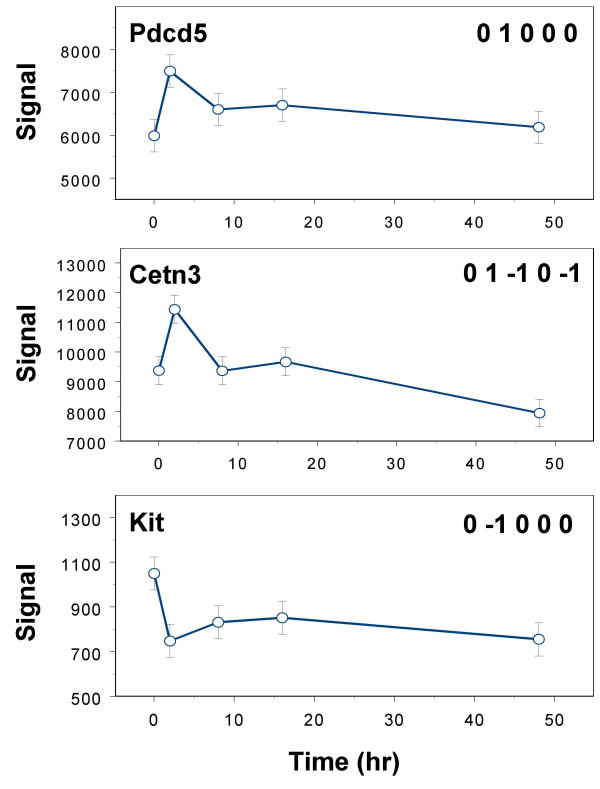
Example diagrams to illustrate expression patterns of genes in Class I. Mean signals (± SD) for genes Pdcd5, Cetn3, and Kit from Class I were plotted. Their expression levels were significantly altered at as early as 2 hr after OBX. Their subsequent expression patterns were different, which was indicated by the indices in each panel.